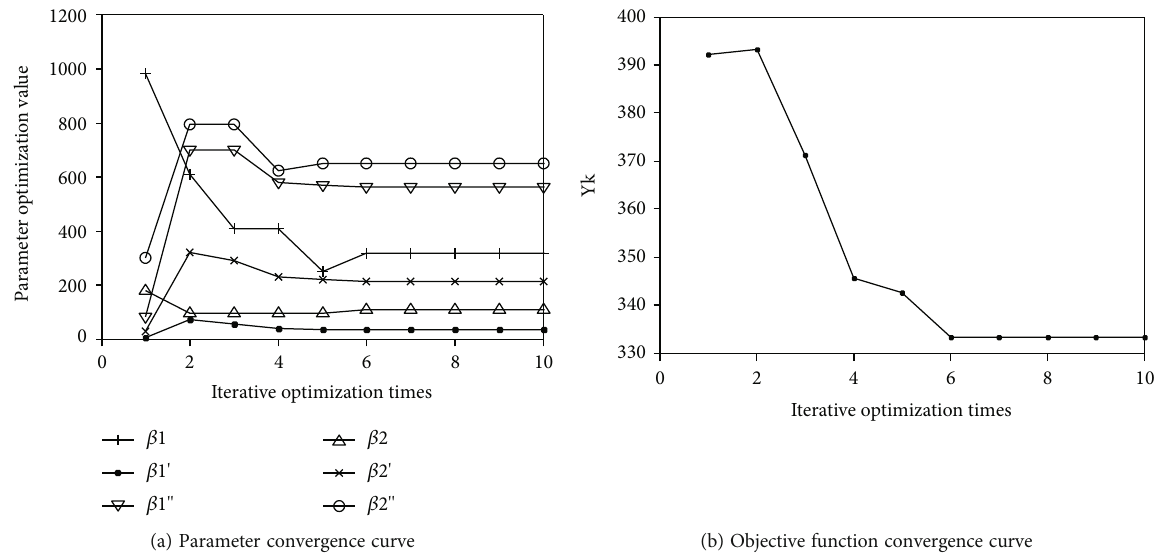
Figure 11: Veri fi cation of the convergence of ant colony active disturbance rejection. Table 2: Parameter meaning of ant colony algorithm.